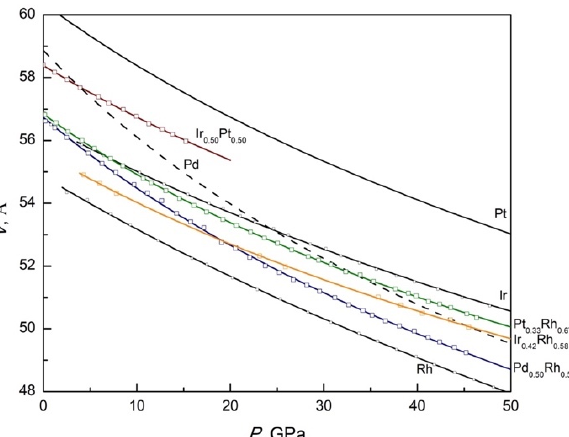
Figure 5. Room temperature high-pressure compressibility curves for fcc -structured Rh, Ir, Pt and Pd binary alloys and pure metals in V / Z vs. P scale (according to Table 3).